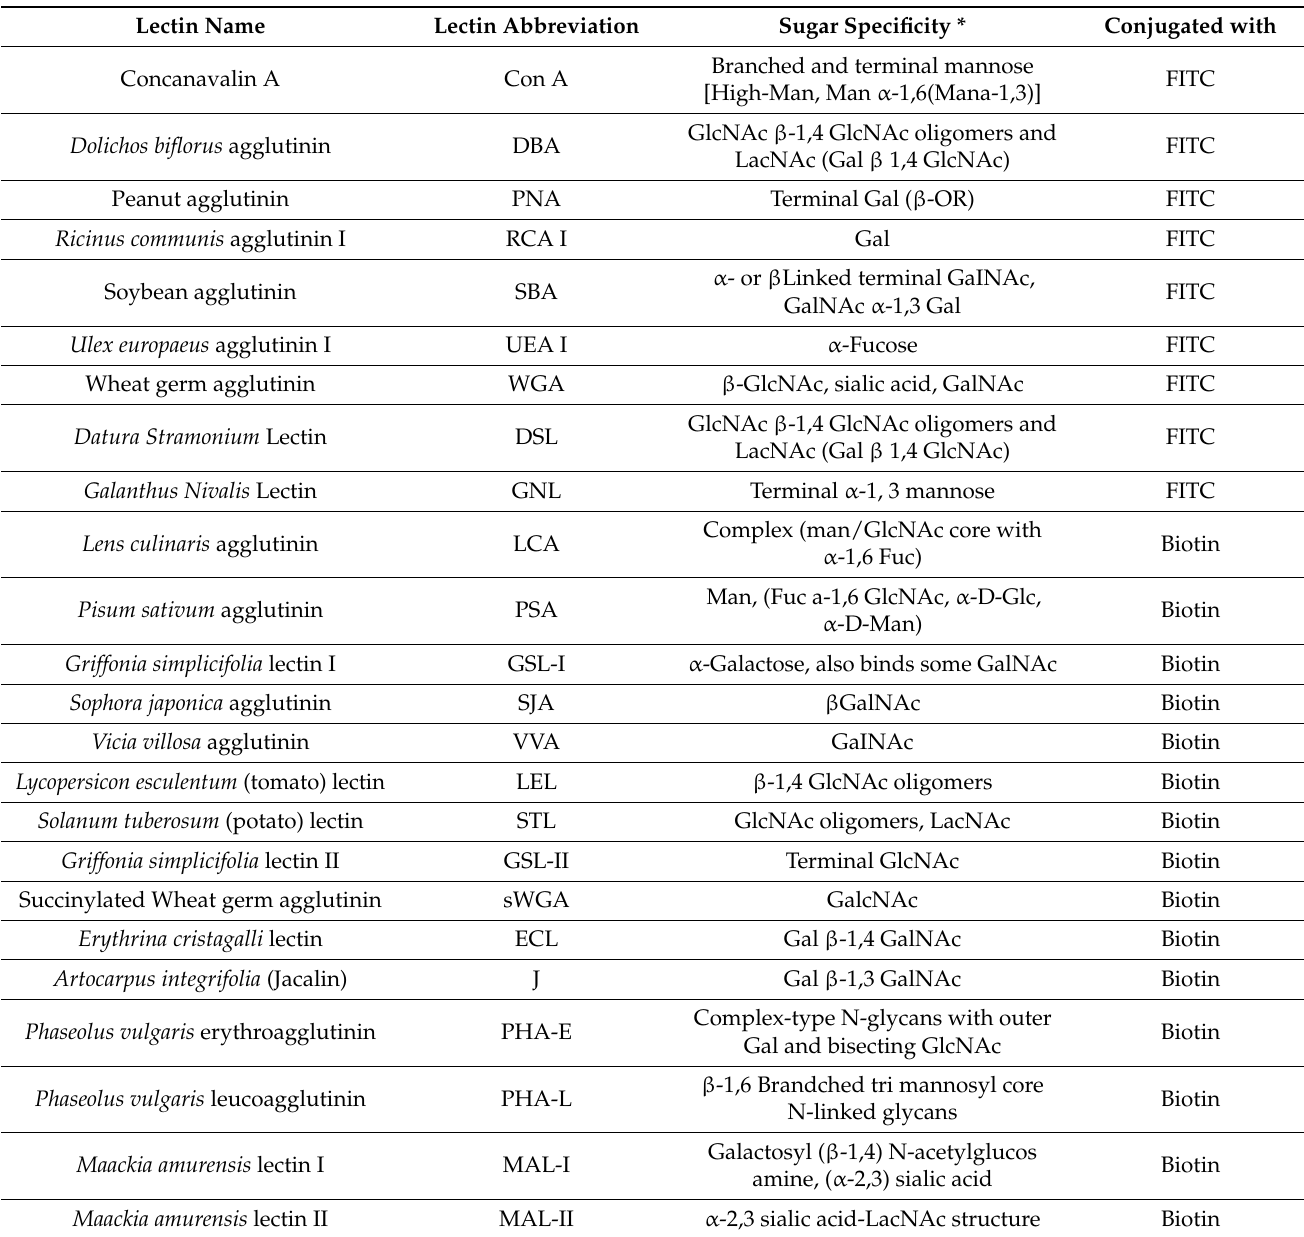
Table 1. List of lectins